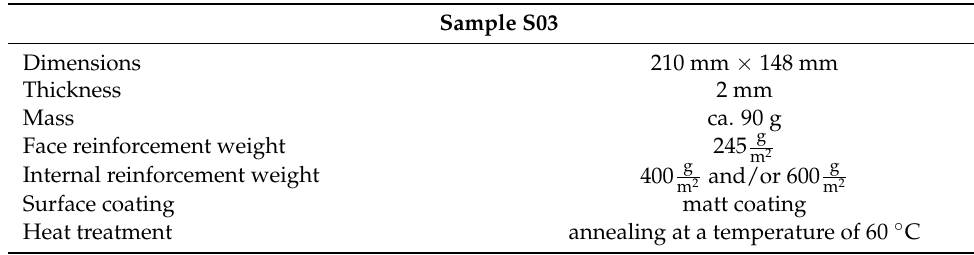
Table 1. Sample parameters.